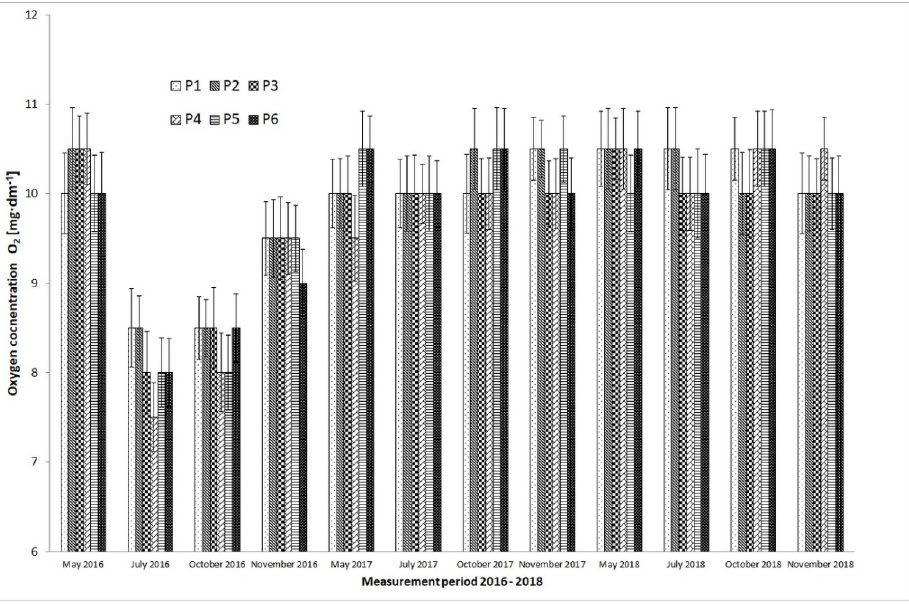
Figure 6. Changes in oxygen concentration in reservoir water in the years